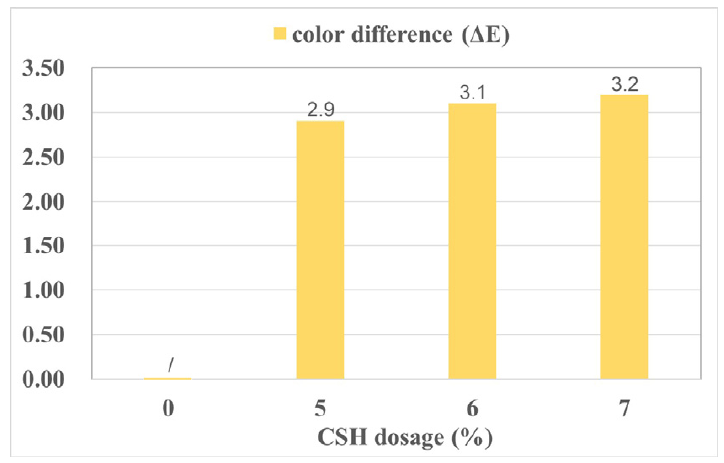
Figure 12. The color difference change in the bone samples after consolidation by CSH.